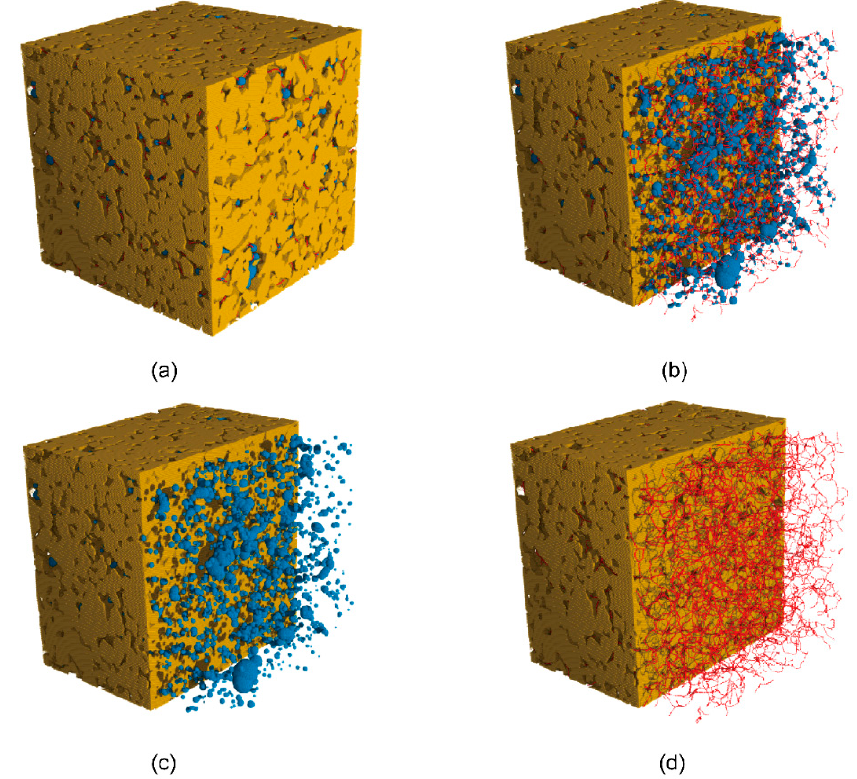
Figure 10. ( a , b ) Solid rendering (yellow), skeleton (red) and inflated pores (blue) of Gildehauser sandstone sample; ( c ) inflated pores; ( d ) skeleton.